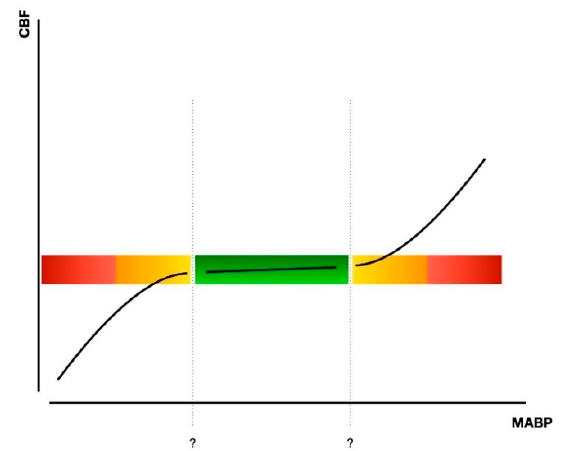
Figure 1. Autoregulatory curve of CBF variations according to mean arterial BP (MABP). In green, the ideal/healthy autoregulatory plateau, and in read/orange the extreme, and therefore dangerous areas of the plot.